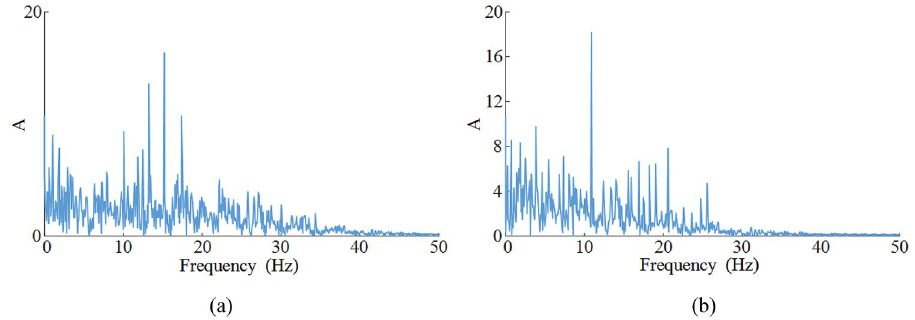
Figure 9. Vibration spectrum of key coal shearer components under slant-cutting tool conditions: ( a ) vibration spectrogram for front ranging arm, ( b ) vibration spectrogram for front walking unit.